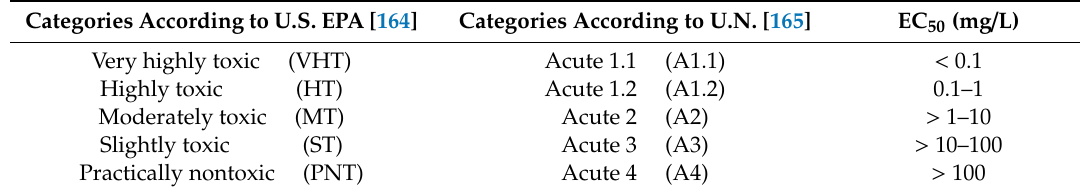
Table 5. Toxicity categories for aquatic